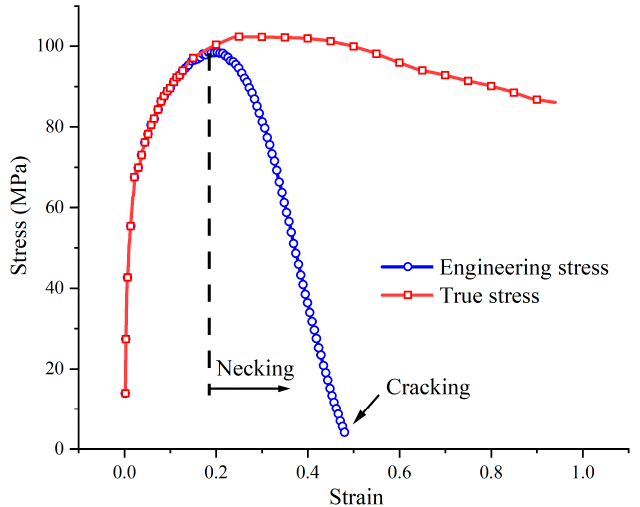
Figure 4. Comparison of engineering stress and true stress of 300M steel under 1050 °C 0.1 s −